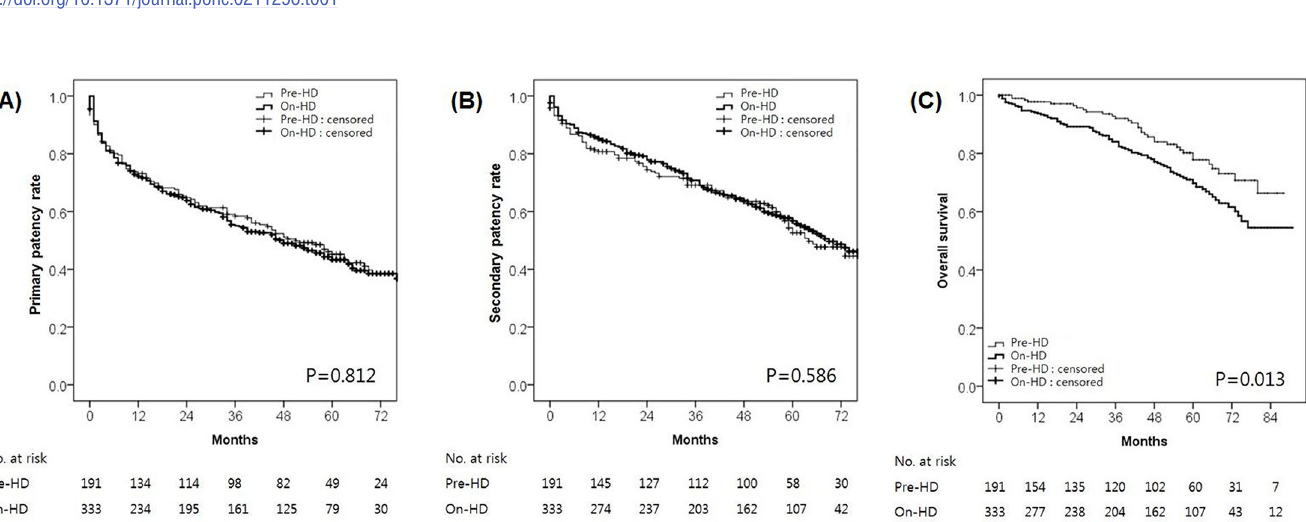
Fig 1. Kaplan–Meier survival analysis. Kaplan–Meier estimates of (A) primary and (B) secondary AVF patency rates, and (C) the overall patient survival rates in pre- HD and on-HD groups. AVF, arteriovenous fistula; HD,